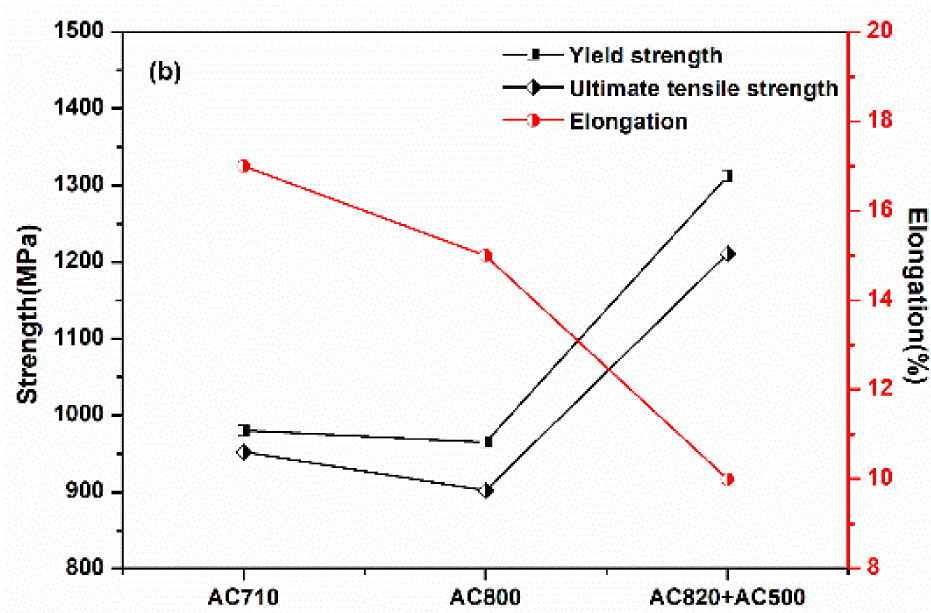
Figure 3. Tensile properties of forged ( a ) SP700 [14] and ( b ) SP700Cr at room temperature. Figure 4 displays the flow stress–strain curves at elevated temperatures (730~790 ◦ C) of the both alloys after AC820 + AC500 at a strain rate of 1 × 10 − 3 s − 1 . It can be seen that the flow stress of both alloys decreases with increasing tensile temperature. As for tensile strain, it initially increases and then decreases with increasing tensile temperature for SP700 alloy and nearly have no change for SP700Cr alloy. From the flow stress–strain curves, it can be clearly seen that the superplasticity is achieved at 750 ◦ C for SP700 alloy (1094%) and at all tensile temperatures for SP700Cr alloy (865–1127%), indicating that Cr is a favorable element to improve the superplasticity for the SP700 alloy. This superplasticity behavior is also clearly seen in Figure 5 before and after fracture at different tensile temperatures of the both alloys after AC820 + AC500, in which the tensile elongation (1127%) of the SP700Cr alloy is much higher than that of the SP700 alloy (1094%).